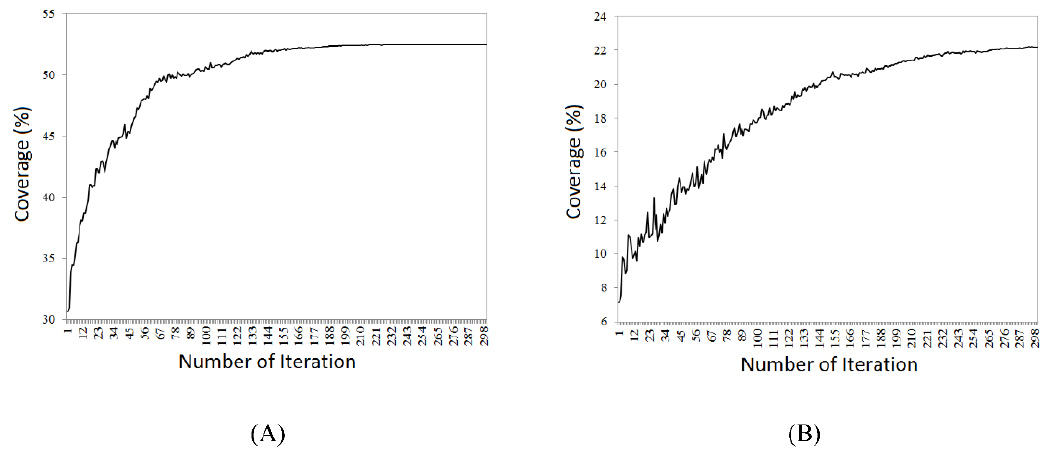
Figure 12. Convergence diagram of probability coverage based on CMAE-ES algorithm for raster models with 100 cm resolution of: ( A ) two-dimensional; and ( B ) three-dimensional.